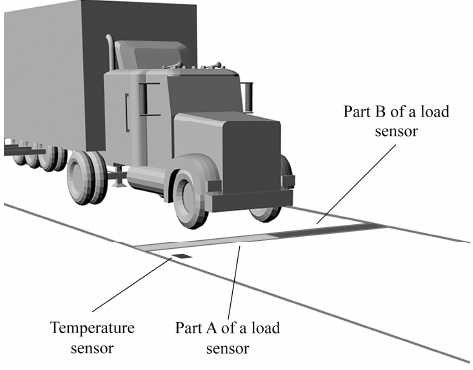
Figure 6. A view of two parts of the load sensor at two different temperatures.